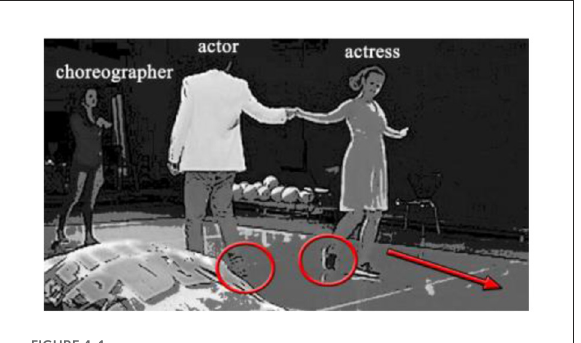
FIGURE4.1 ACF realizes an intermediate